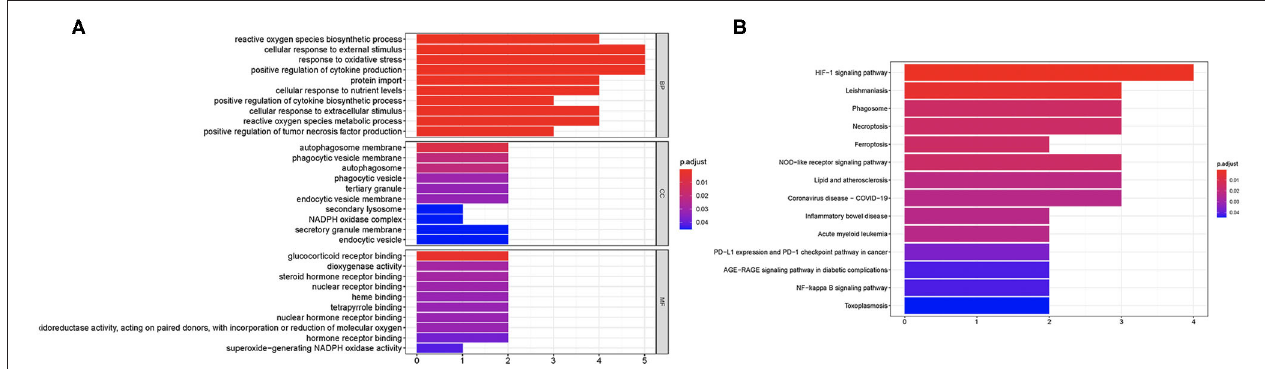
FIGURE 2 | Enriched items in GO and KEGG analysis using ferroptosis-related DEGs. (A) The enriched items in GO analysis. (B) The enriched items in KEGG pathway analysis. DEGs, differentially expressed genes; GO, Gene Ontology; BP, biological process; CC, cellular component; MF, molecular function; KEGG, Kyoto Encyclopedia of Genes and